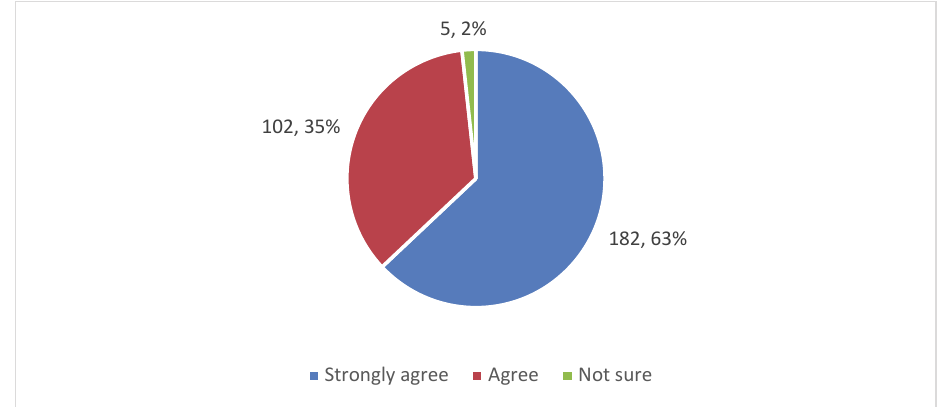
Fig. 4. Opinions on marketing practices and organizational